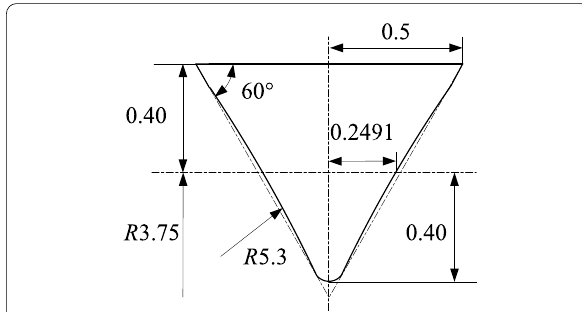
Figure 11 Rotational removal profile of